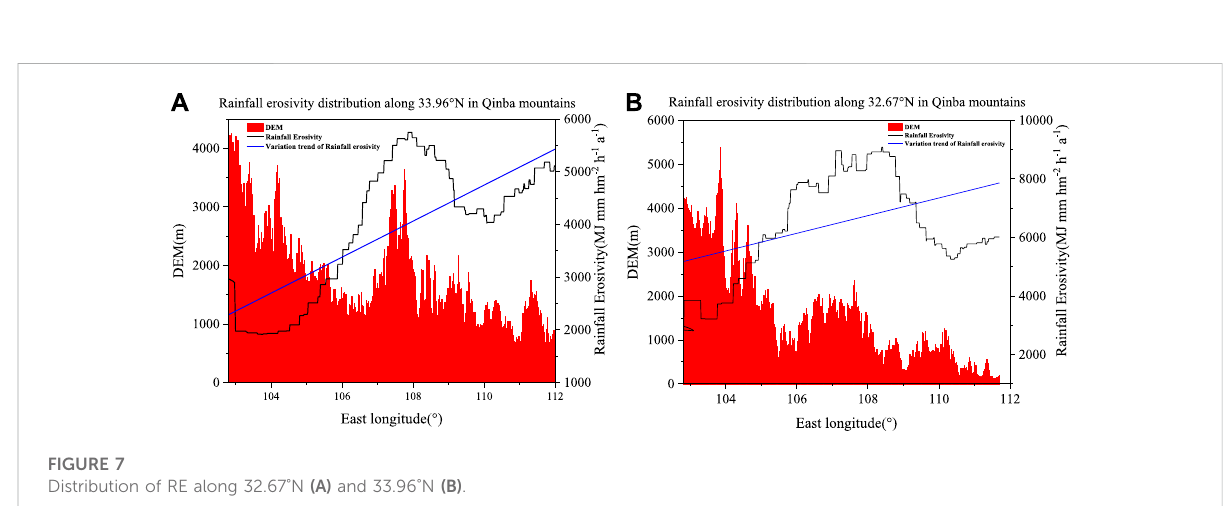
FIGURE 7 Distribution of RE along 32.67 ° N (A) and 33.96 ° N (B)